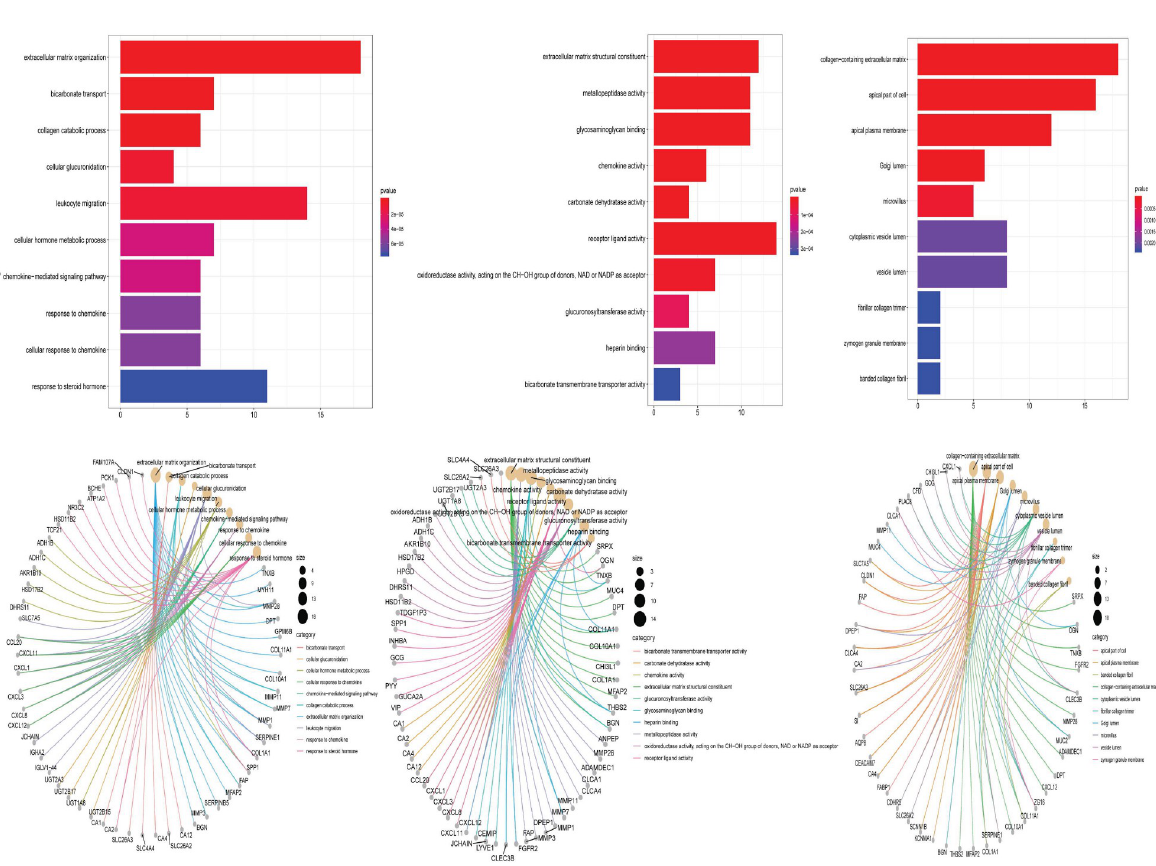
Fig 19. Functional enrichment analysis box plots and cnet plots. The left collumn) Biological Processes. The middle collumn) Molecular Functions. The right collumn) Cellular Components.